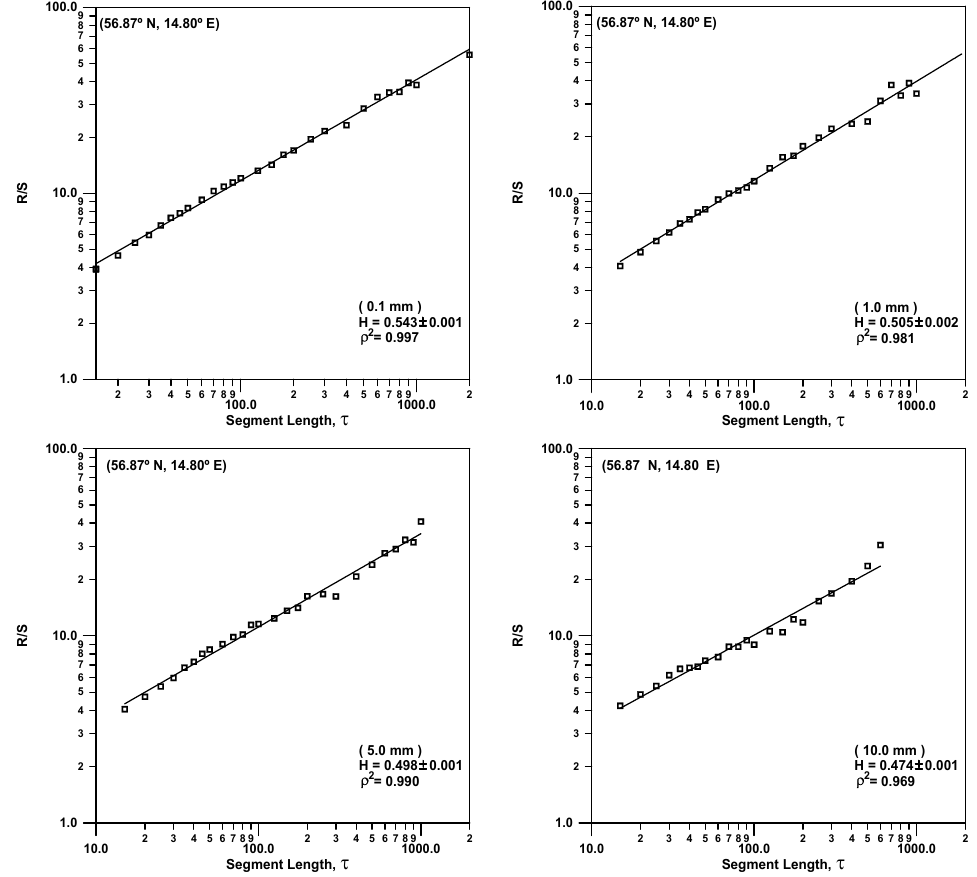
Fig. 5. An example of rescaled analysis for the DSL series and the four thresholds (0.1, 1.0, 5.0 and